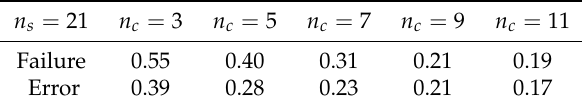
Table 4. Failure rate and error rate (21